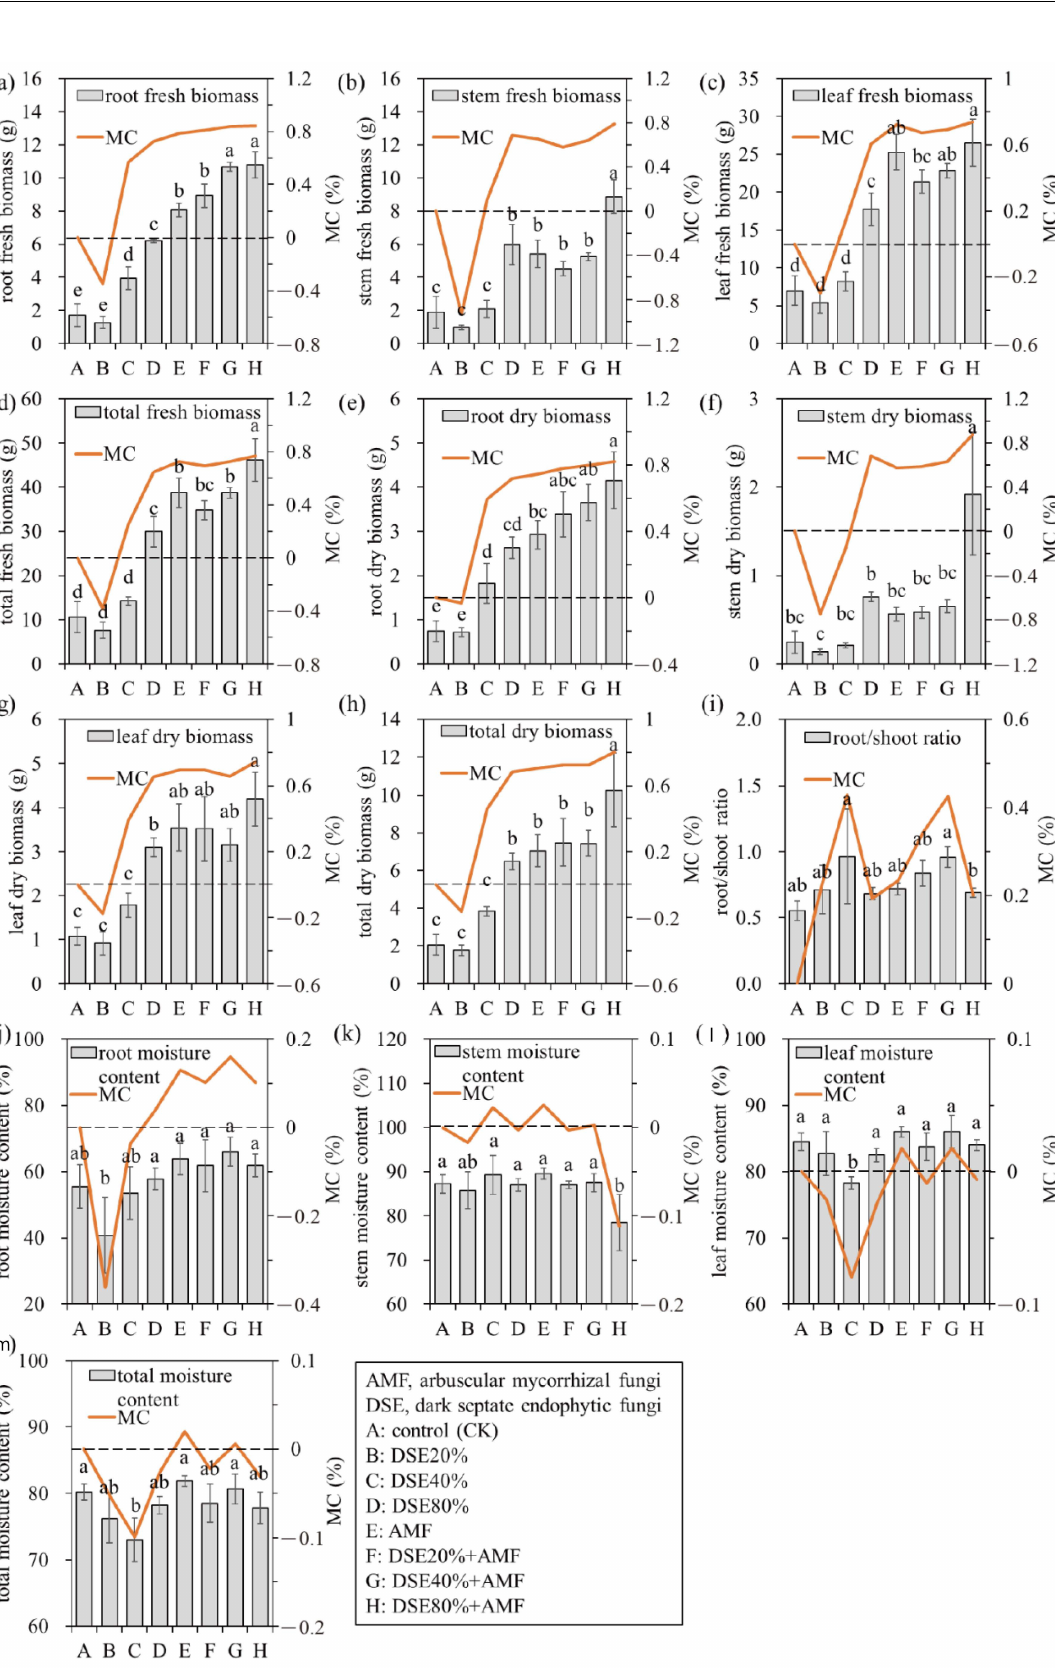
Figure 1. Plant growth indexes of different inoculation treatments. ( a ) Root fresh biomass and mycorrhizal contribution (MC); ( b ) Stem fresh biomass and MC; ( c ) Leaf fresh biomass and MC; ( d )